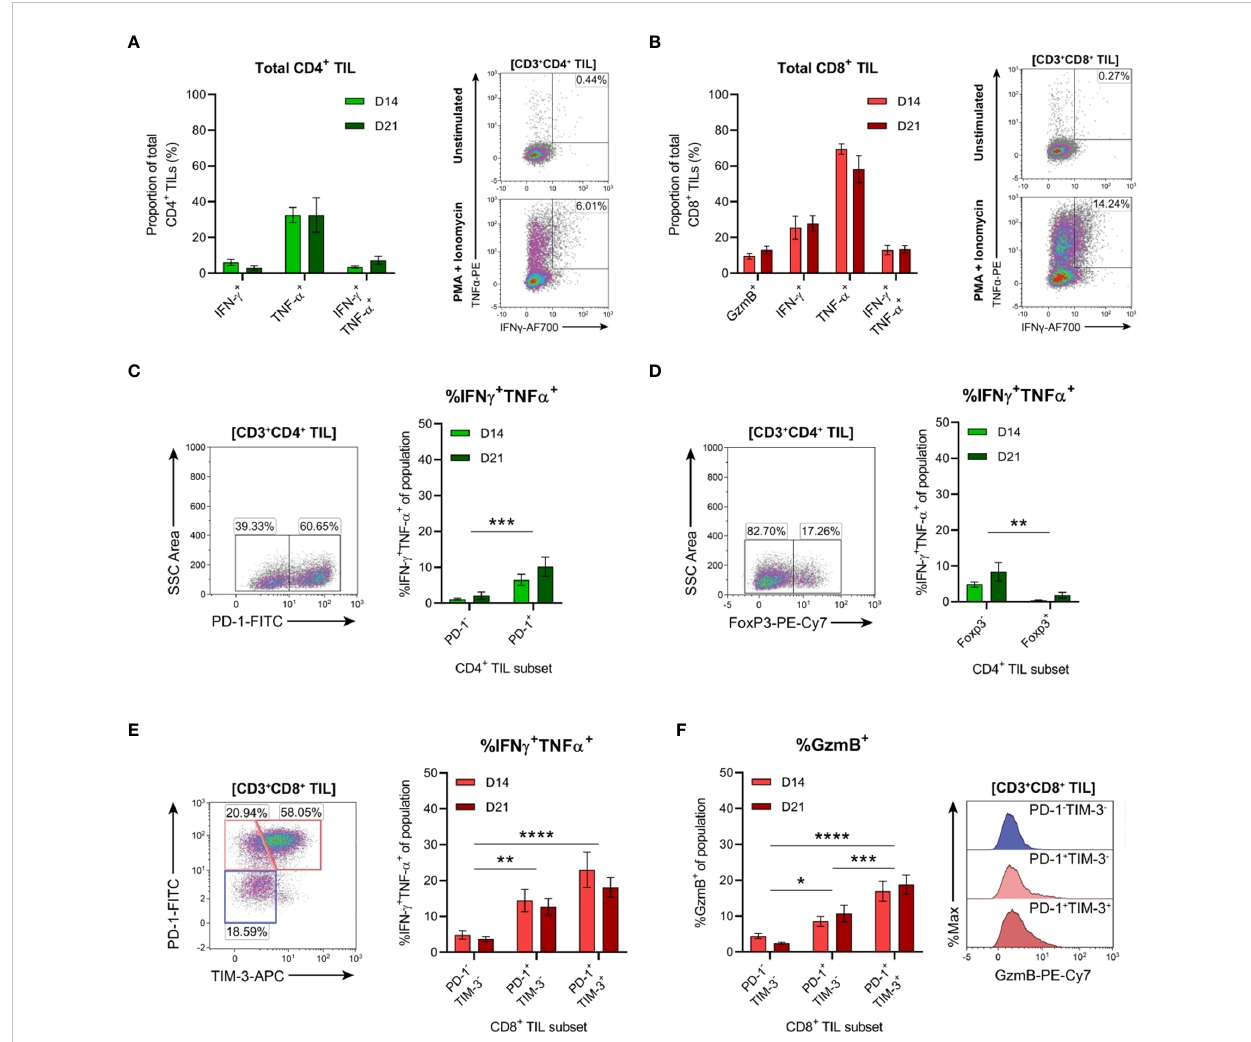
FIGURE 9 Tumour-in fi ltrating CD4 + and CD8 + T cell subsets exhibit distinct functional properties. (A, B) Frequency of cytokine producing cells within total CD3 + CD4 + (A) and CD3 + CD8 + (B) TILs. Representative density plots depict IFN- g and TNF- a production by total CD3 + CD4 + and CD3 + CD8 + TILs in unstimulated controls (top) and following PMA+ionomycin stimulation (bottom). (C, D) Representative density plots depicting PD-1 (C) and FoxP3 (D) subset gating in CD3 + CD4 + TILs and frequencies of cells producing both IFN- g and TNF- a (%IFN- g + TNF- a + ) within PD-1 and FoxP3 subsets. (E) Representative density plot depicting PD-1 and TIM-3 subset gating in CD3 + CD8 + TILs and frequencies of cells producing both IFN- g and TNF- a (%IFN- g + TNF- a + ) within these subsets. (F) Frequency of cells producing granzyme B (%GzmB + ) within PD-1 and TIM-3 subsets (CD3 + CD8 + TILs) and representative histogram overlays. All density plot percentages indicate frequencies as the proportion of the gated population (indicated in bold titles with square brackets). Graphs represent the mean and standard error of the mean (SEM, error bars). Statistical analyses were performed using two- way ANOVA with post-hoc Tukey test to correct for multiple comparisons, or by multiple unpaired Student ’ s t -tests, using the Holm-Sidak method to correct for multiple comparisons. *p ≤ 0.05; **p ≤ 0.01; ***p ≤ 0.001; ****p ≤